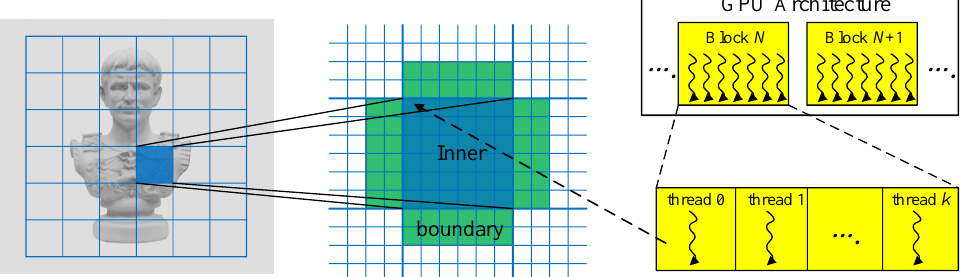
Figure 6. GPU-based parallel refinement. The ROI is firstly subdivided into squared patches ( left ), and all pixels in one single patch are simultaneously optimized with an additional two-pixel wide boundary for derivatives computation and regularization ( middle ). On GPU, each patch is processed by one thread block that has the same number of threads as the pixels in the patch ( right